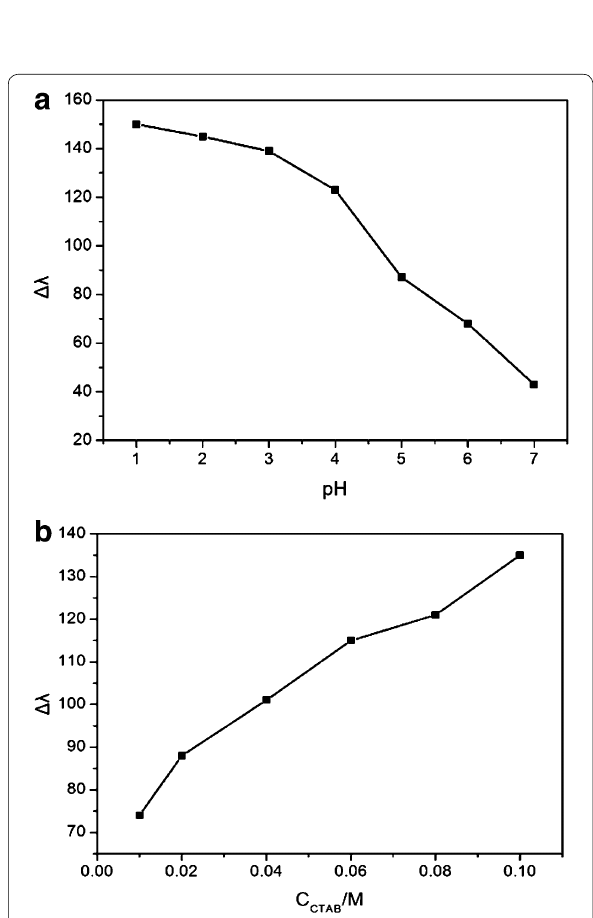
Fig. 6 Effect of a pH and b concentration of CTAB on the peak shift (Δλ) of AuNR@Ag in the presence of 10 μM